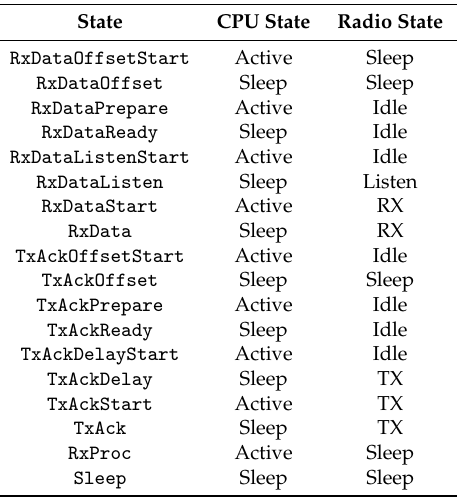
Table 2. States in a RxDataTxAck slot.